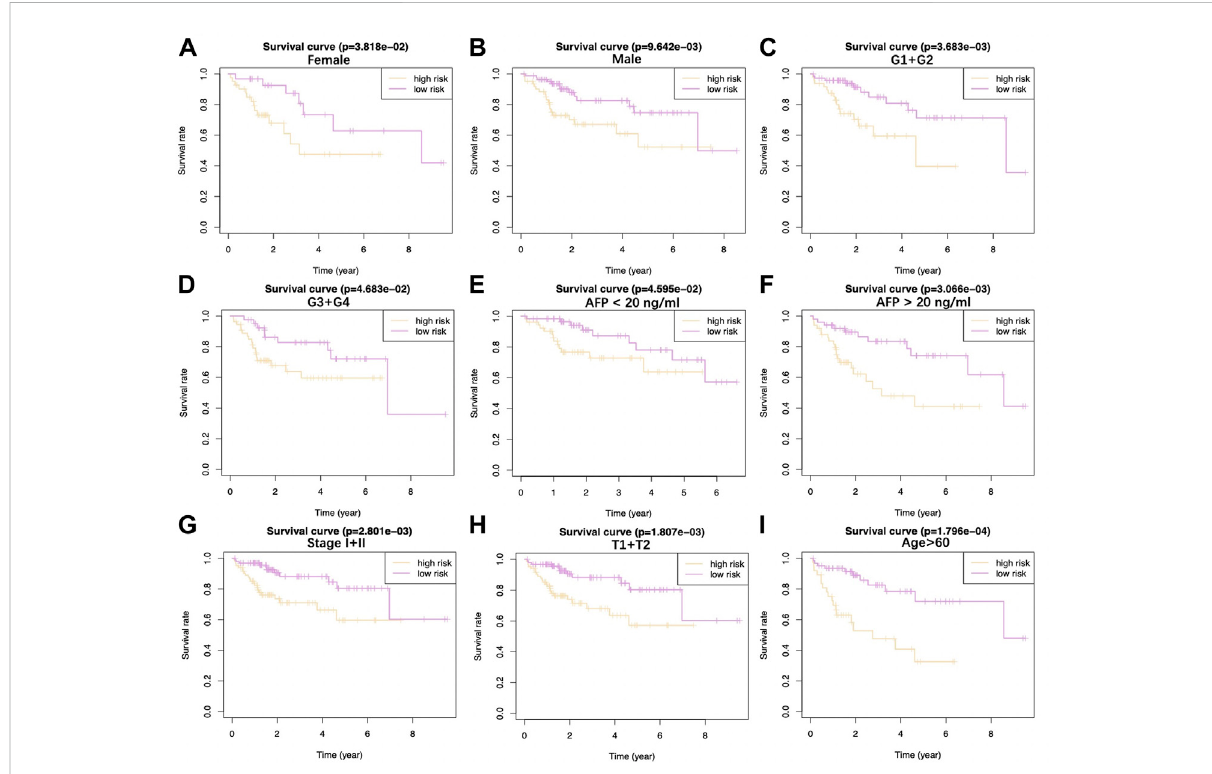
FIGURE 3 Difference in OS between two TCGA-HCC cohorts are presented after strati fi cation by gender (A , B) , tumor grade (C , D) , AFP level (E , F) , clinical stage (G) , T stage (H), and age (I)